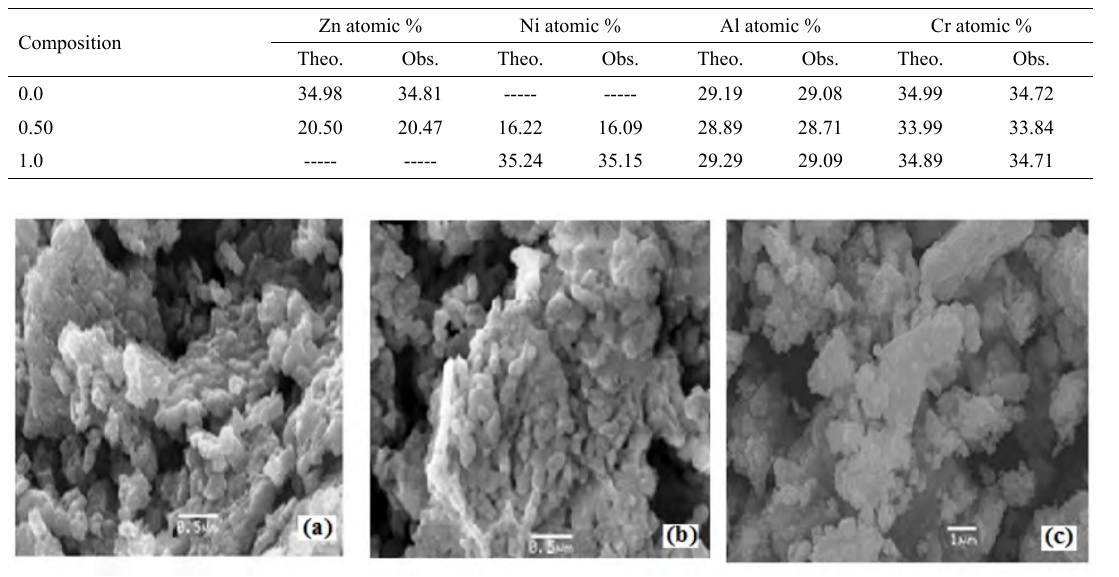
Table 2. Results of EDAX of Zn